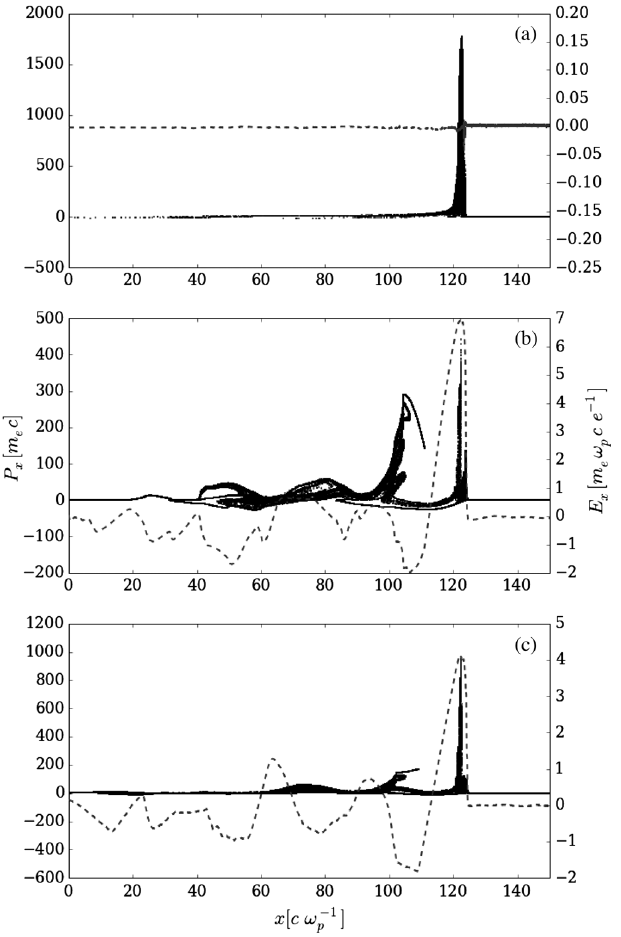
FIG. 2. The longitudinal P x momentum gain with relativistic FIG. 1. The longitudinal P x momentum gain with relativistic waves, as a function of relativistic wave amplitude: phase-space waves, a process dependent on the mass ratio: phase-space diagrams showing the effect of electromagnetic waves of in- diagrams showing the effect of an electromagnetic wave of the creasing intensity on plasmas of the same mass ratios ( m i same intensity ( a 0 ¼ 20 ) on plasmas of differing mass ratios (a) a 0 ¼ 0 . 4 , (b) a 0 ¼ 2 , and (c) a 0 ¼ 60 . The dotted lines ¼ 1 , (b) m i ¼ 100 , and (c) m i ¼ 1836 . The dotted lines (a) m i m e m e m e represent the electric field in the longitudinal direction. These represent the electric field in the longitudinal direction (whose three cases most clearly illustrate the differences between the amplitude is shown on the right vertical axis, while the momen- subrelativistic (WA only), slightly relativistic (WA and PA), and tum gain is shown on the left abscissa). We observe a prominent ultrarelativistic (PA only) regimes. In the slightly relativistic group of accelerated electrons ahead of the laser pulse due to PA, regime, the figure shows the wave breakings which destroy the followed by wakefield accelerated electrons in (b) and (c). In (a), wakefield structure, allowing the PA to become the dominant electrons are only accelerated by PA. acceleration as a 0